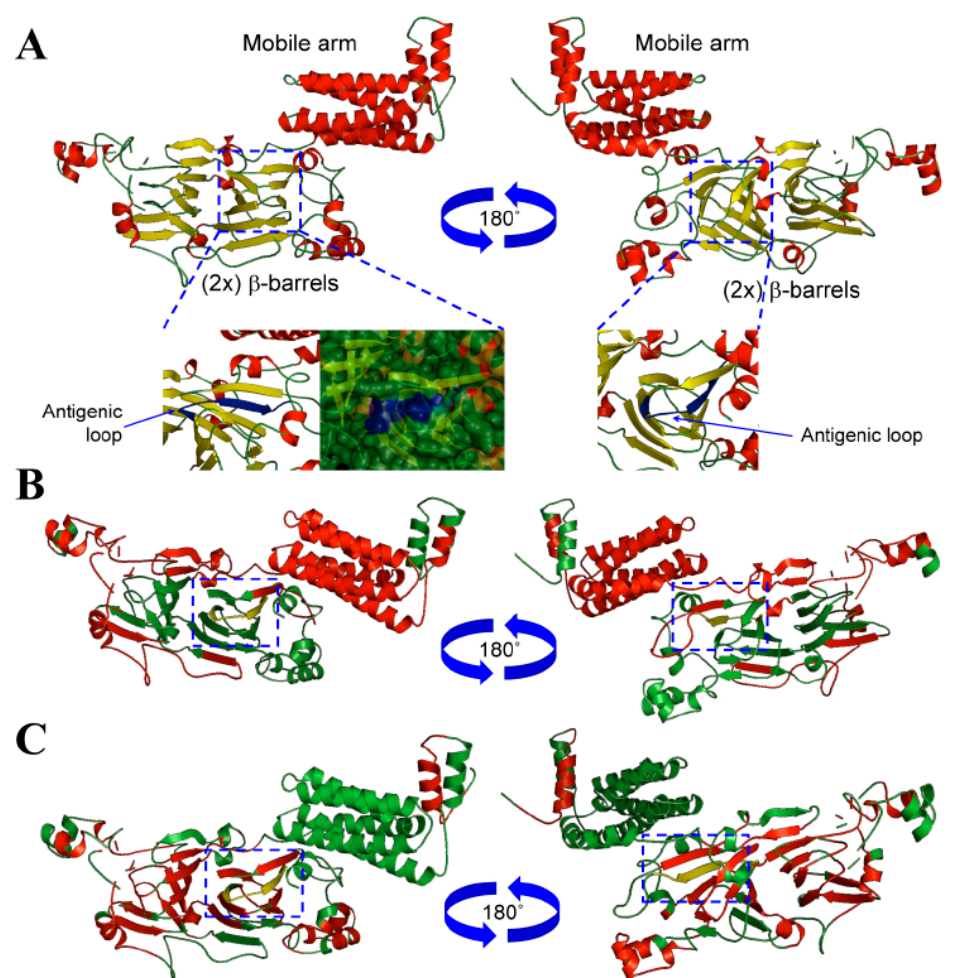
Figure 1. Structural and antigenic analysis of conglutin β 1. ( A ) Three-dimensional structure of NLL conglutin β 1 (Uniprot accession number F5B8V9) showing the mobile arm and globular domains. The structures were depicted as a cartoon diagram integrated by α -helices, β -sheets and coils (red, yellow and green colour, respectively). Two views (rotated 180 around the x -axis) are provided together with detailed views (carton diagram and surface) of the domain integrated by a coil- α -helix structure (blue colour), where the antigenic peptide chosen to develop the anti- β -conglutin antibody is located. ( B ) Three-dimensional structure depicted as a cartoon diagram of NLL conglutin β 1 showing the antigenic β -cell sequential epitope regions (red colour), where the domain integrated by a coil- α -helix structure (yellow colour) are included. Two views (rotated 180 around the x -axis) are provided. ( C ) Three-dimensional structure depicted as a cartoon diagram of NLL conglutin β 1 showing the Kolaskar and Tongaonkar antigenicity regions (red colour), where the domain integrated by a coil- α -helix structure (yellow colour) are also included. Two views (rotated 180 around the x -axis) are provided.